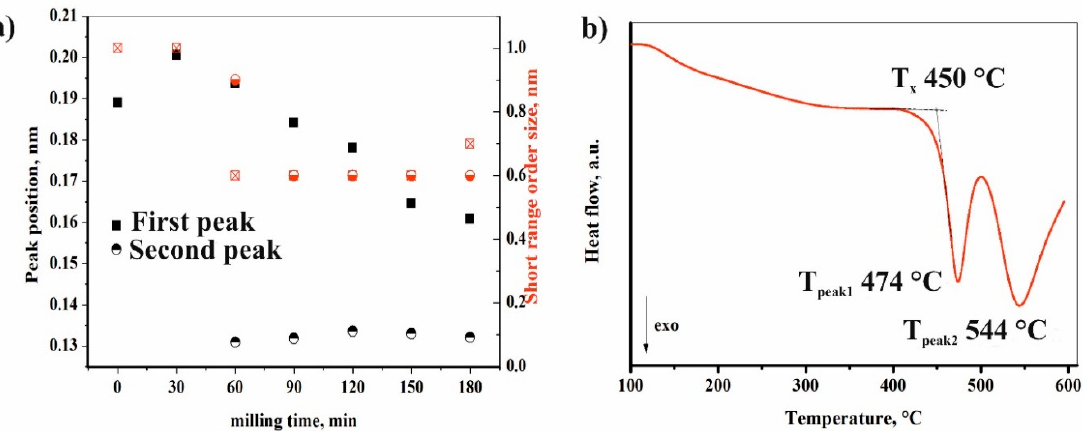
Figure 8. Effect of milling time on features of amorphous content ( a ) and constant heating rate (40 ◦ C/min) DSC trace; ( b ) obtained for Ti 50 Cu 25 Ni 20 Sn 5 alloy after 180 min of milling. Table 2. Features of amorphous structure based on the XRD in the case of Ti 50 Cu 25 Ni 20 Sn 5 alloy. Milling Time,